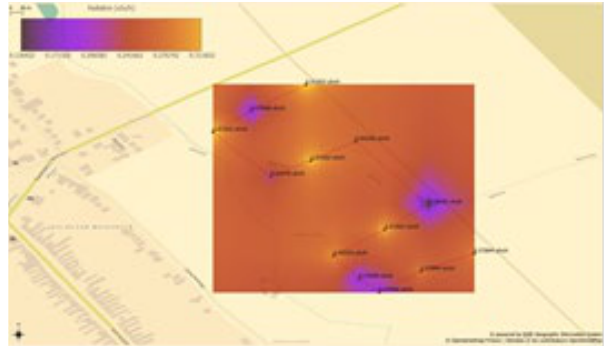
Fig. 5. Radiation map from the demonstration